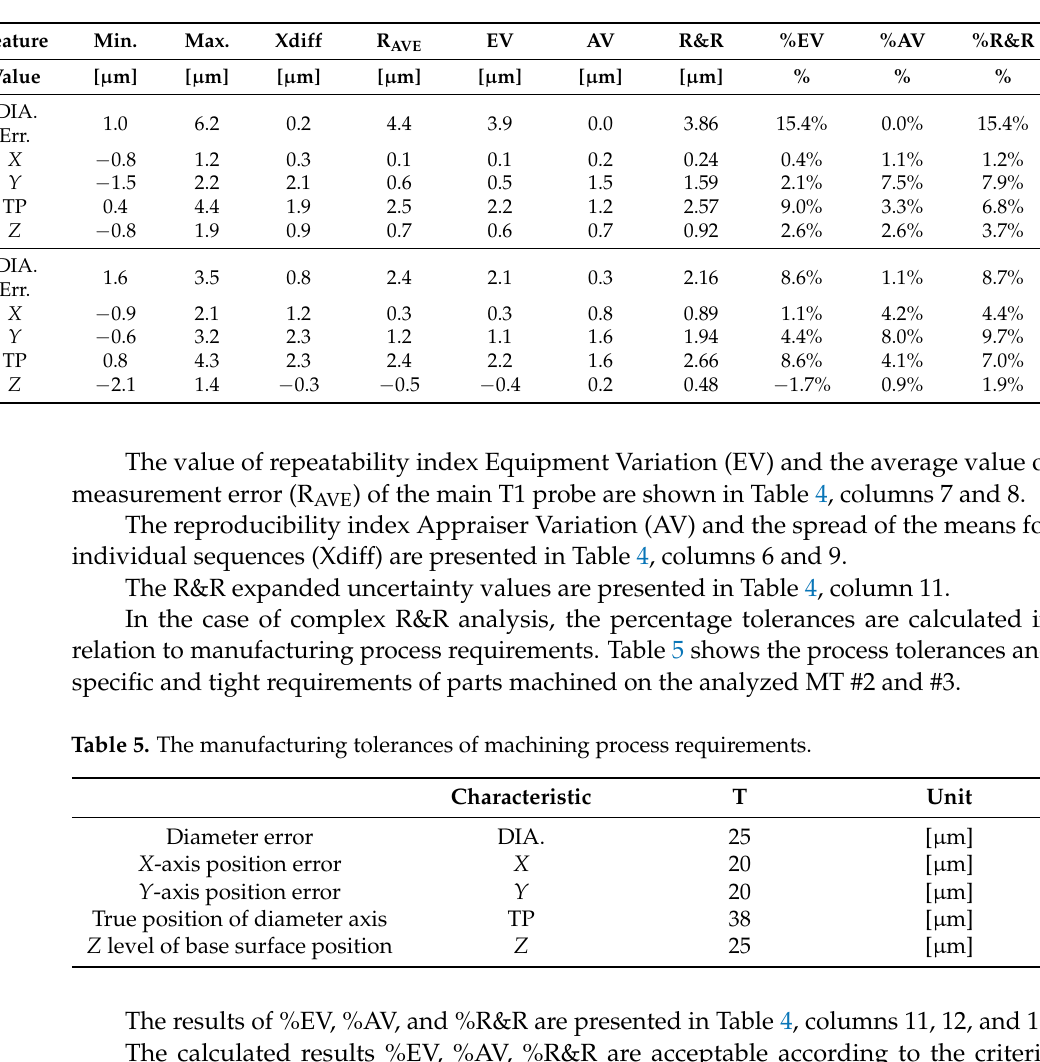
Table 4. The R&R analysis results of MT#2 and #3 measurement system quality, repeatability, and reproducibility values.